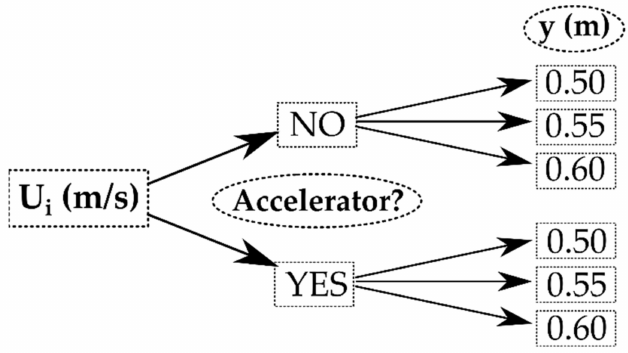
Figure 7. Outline showing how the tests were carried out.